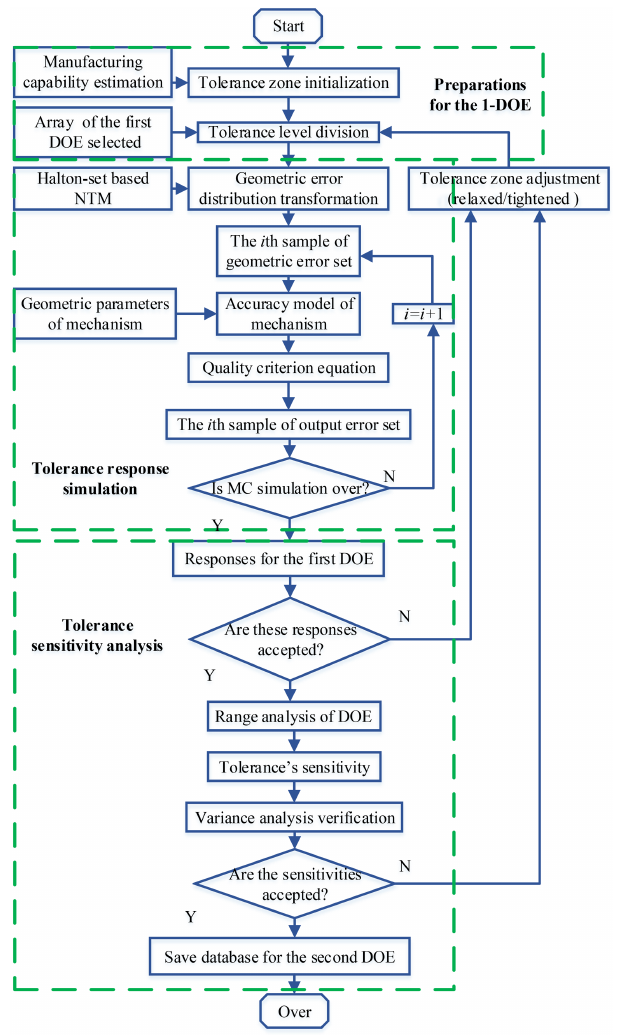
Figure 6. Scheme for the first stage of DOE for the L/R mecha- nism’s tolerance